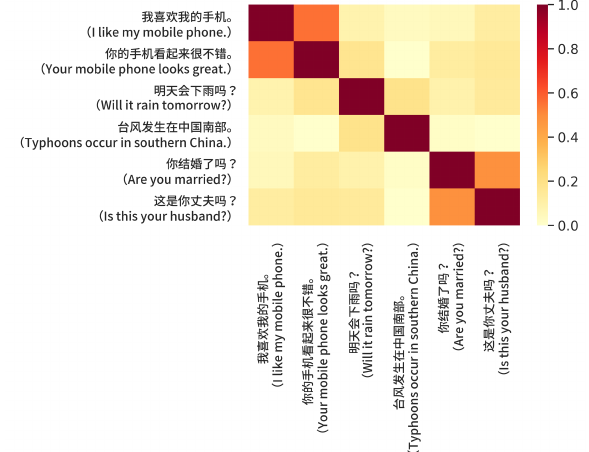
Figure 2. Sentence similarity scores using embeddings from the Chinese version of the universal sentence encoder (Cer et al., 2018). Note that the darker the cell, the greater the sentence similarity. Hence, the diagonal cells are the darkest since they represent self-similarity. The sentence pairs relating to phones and marriage are considered most similar when com- pared to the pair relating to weather. This may be due to the absence of overlapping words and word stems in the latter two